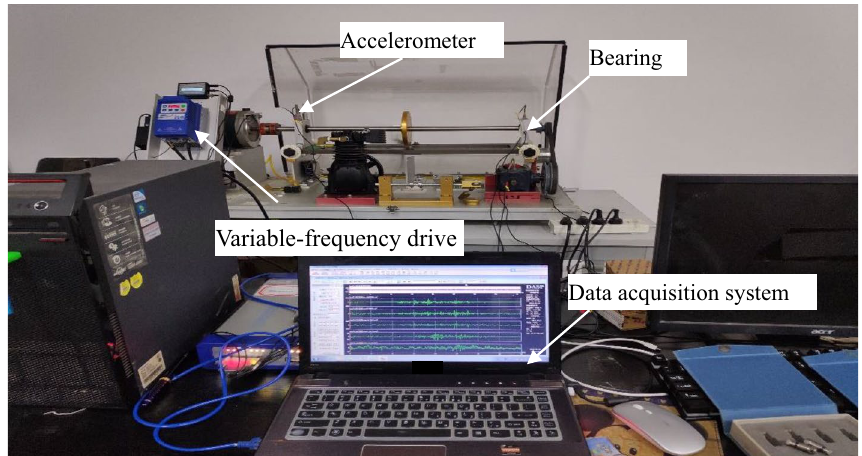
Figure 3. The MFS-MG test rig.